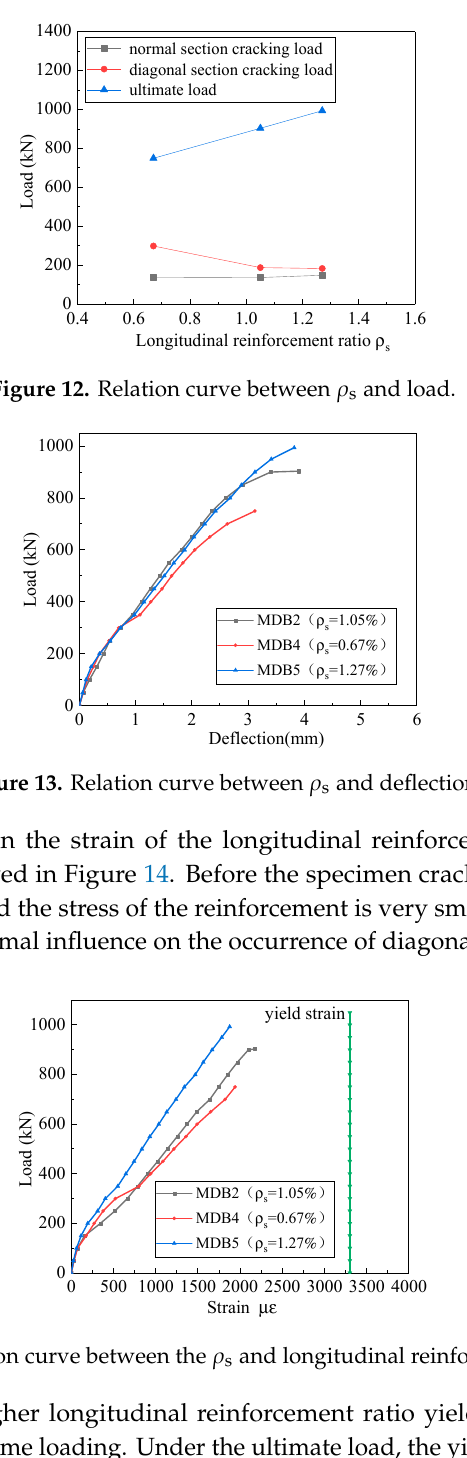
Figure 15. Relation curve between ρ s and horizontal distributing reinforcement strain.